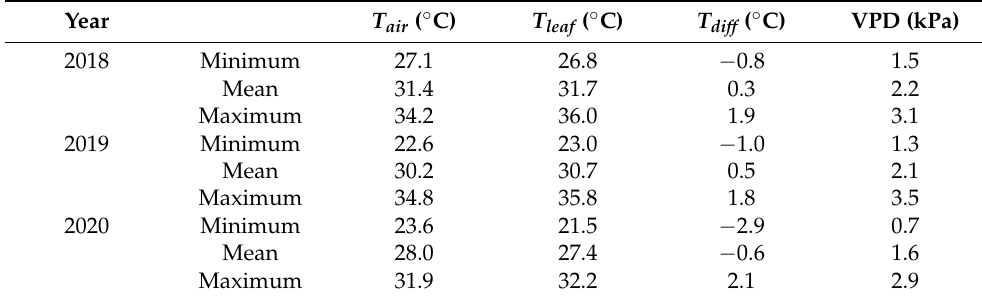
Table 1. Descriptive statistic used to establish the g sw status model.